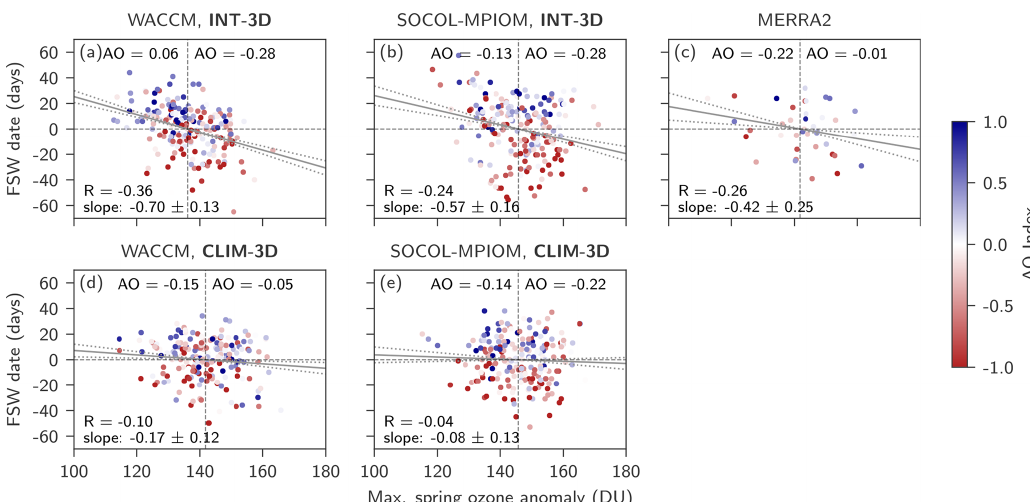
Figure 3. Correlation of the FSW date and preceding springtime ozone. Linear regression of the maximum 5d running mean partial ozone column between 20 February and the FSW on the deviation of the FSW date from its mean in the respective year in WACCM INT-3D (a) , SOCOL-MPIOM INT-3D (b) , MERRA2 (c) , WACCM CLIM-3D (d) , and SOCOL-MPIOM CLIM-3D (e) . Colors represent the AO index in the month after the FSW date, solid grey lines show the linear regression. “R” denotes the Pearson correlation coefficient. Vertical stippled grey lines mark the mean ozone value over all years. Mean AO indices are given for years with especially high (right) or low (left)